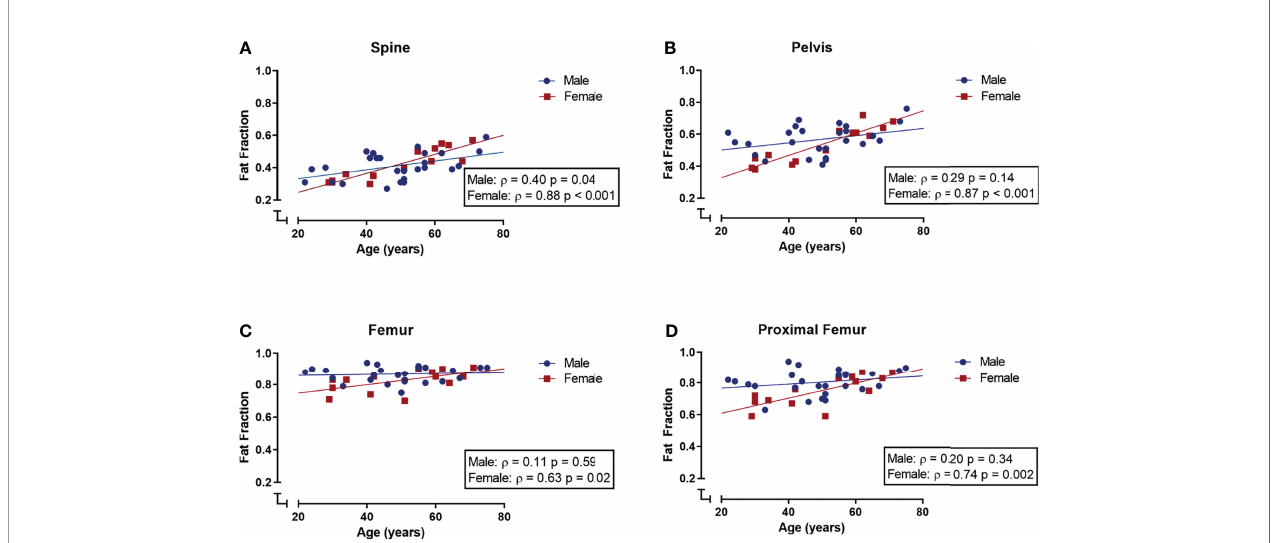
FIGURE 4 | Correlations (Spearman ’ s rank correlation coef fi cient) between age and bone marrow fat fraction ( S FF ) in male (blue) and female (red) subjects. (A) Spinal fat fraction and age were positively correlated in both male and female subjects. (B – D) Within the pelvis, femur, and proximal femur fat fraction and age were positively correlated in female subjects but not in male